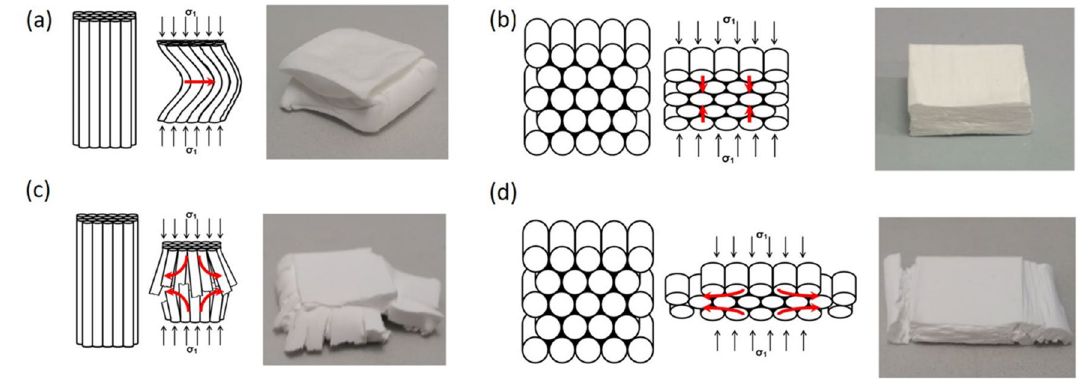
Figure 5. Schematical description of the failure behavior: ( a ) Pure PVA and PVA/MFC (axial) ( b ) Pure PVA and PVA/MFC (transversal), ( c ) PVA/SiO 2 and PVA/NC (axial), and ( d ) PVA/SiO 2 and PVA/NC